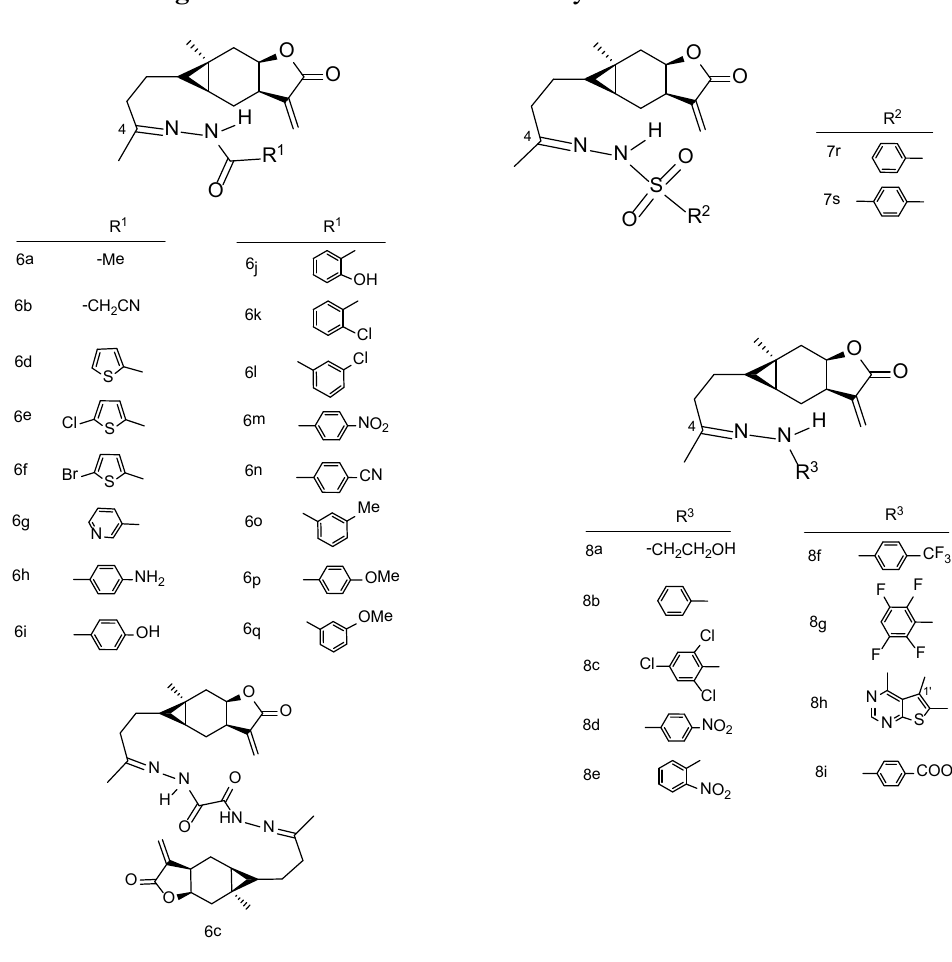
Figure 2. Structures of carabrone hydrazone